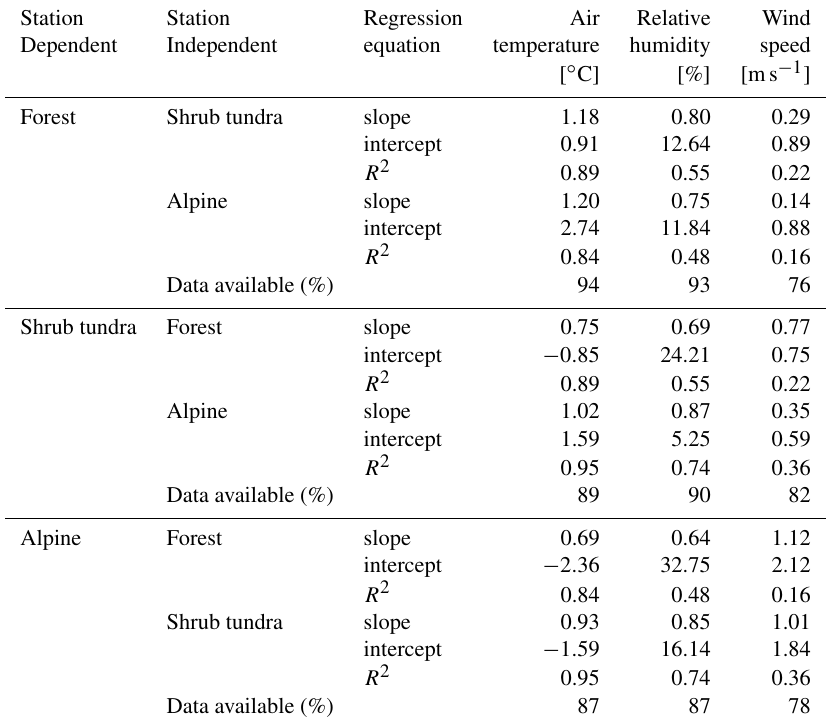
Table 5. Regression equations used to fill the gaps in meteorological variables in the three stations representing forest, shrub tundra, and alpine biomes in the Wolf Creek Research